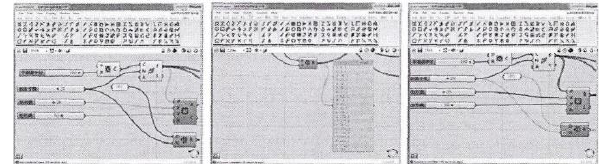
Figure 5: Modeling in the second stage